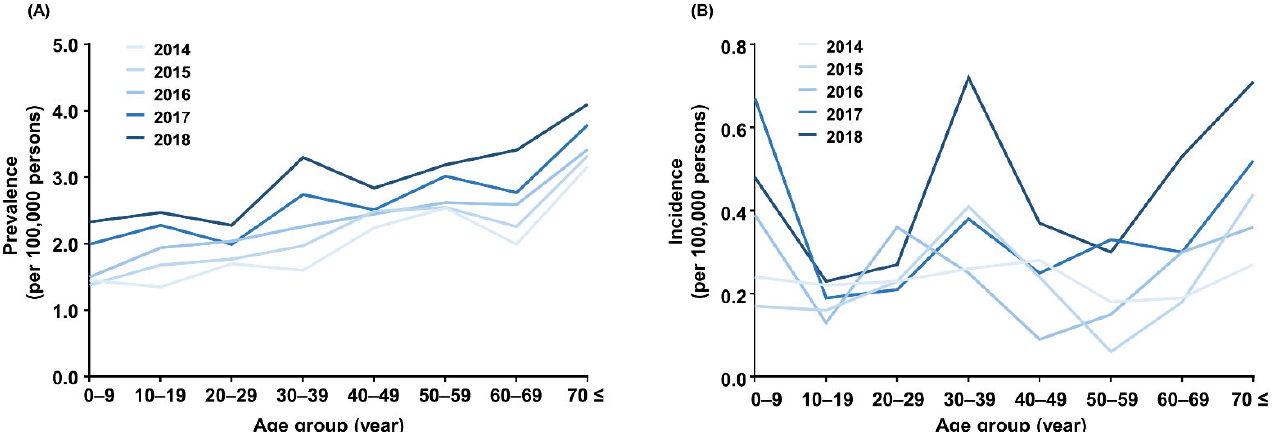
Figure 2. The ( A ) prevalence and ( B ) incidence of thalassemia in each age group.